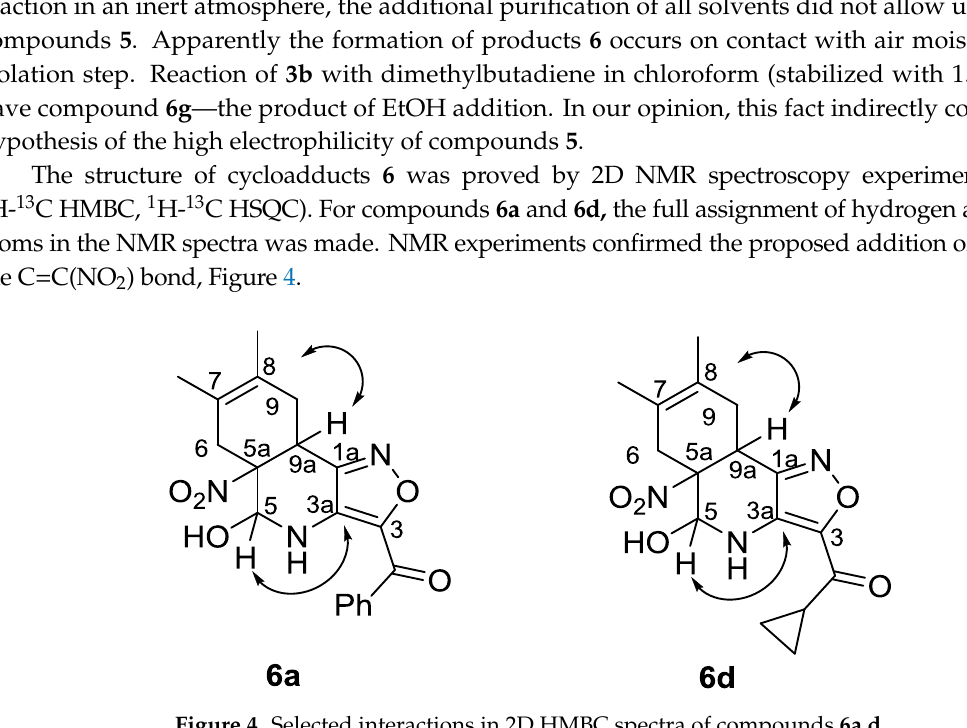
Figure 4. Selected interactions in 2D HMBC spectra of compounds 6a,d.